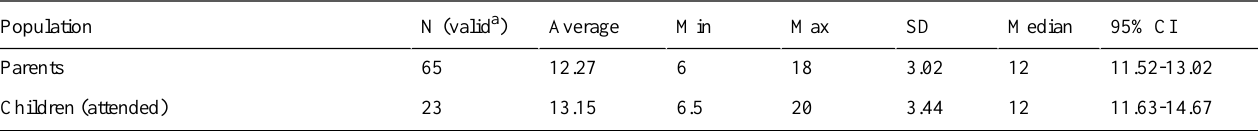
Table 16. Opinions about minimum age to join an emergency response community (all values in